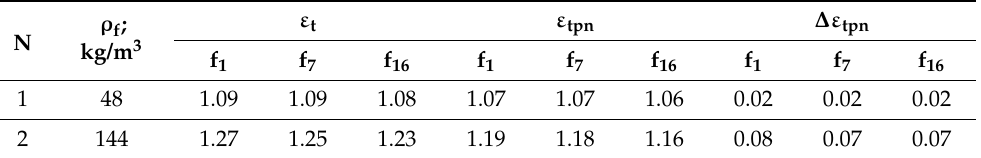
Table 3. Influence of a penetrating air gap on the true permittivity, 1 kHz.